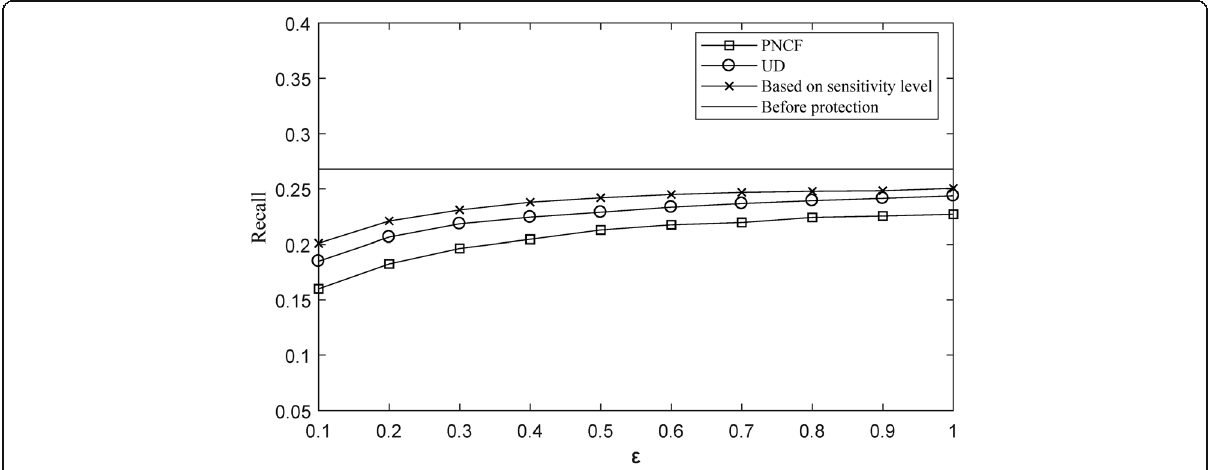
Fig. 7 Impact of differential privacy protection on recall